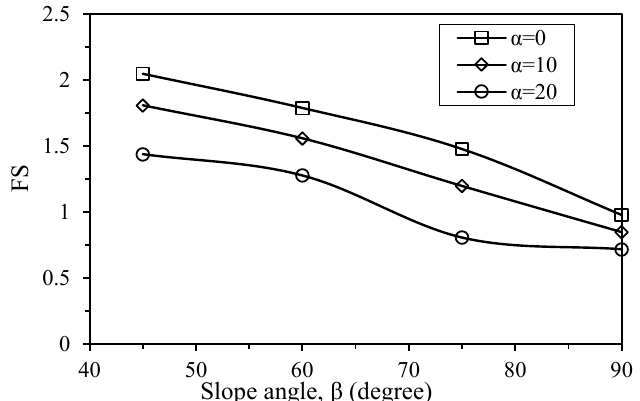
Figure 4. Relationship between factor of safety (FS) and slope angle for different backslopes.